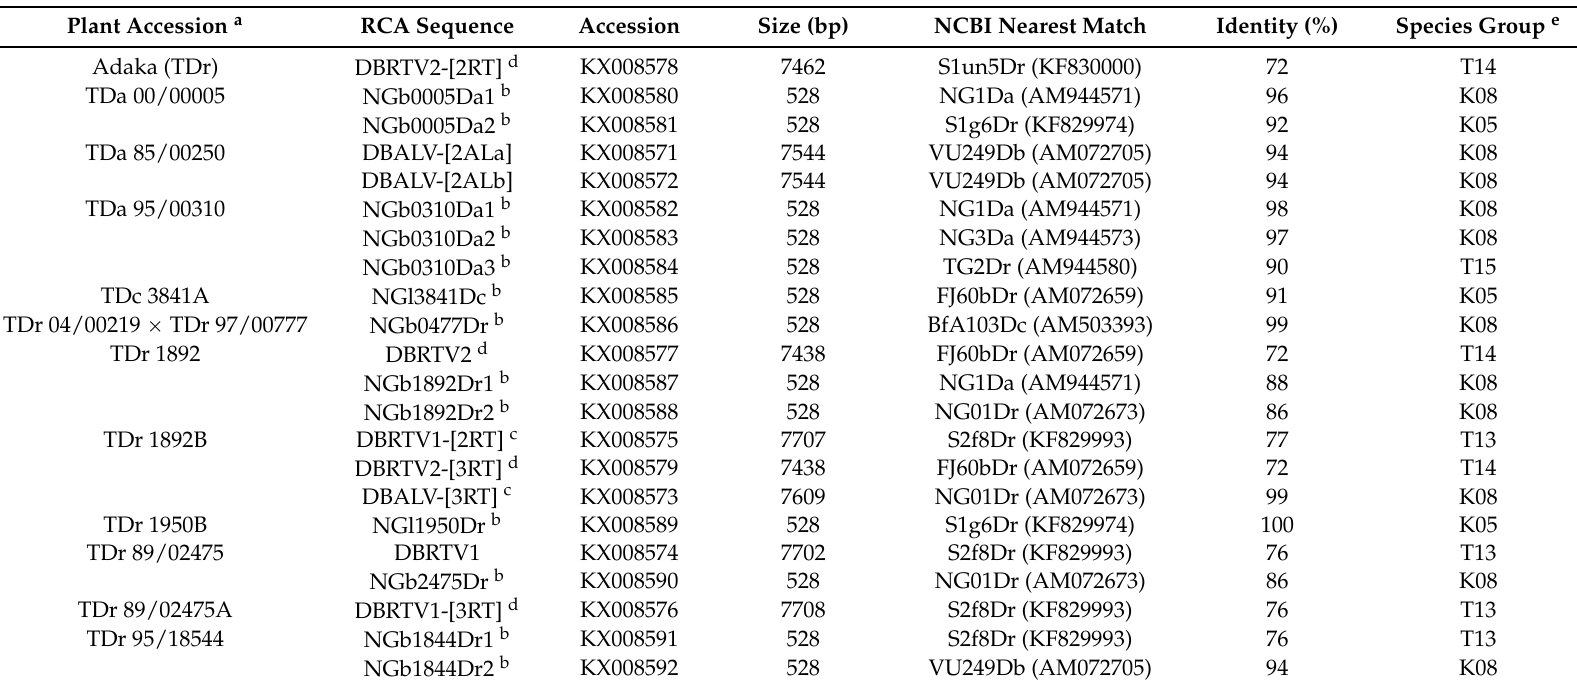
Table 1. RCA-derived sequences and BLAST analysis of their partial RT-RNaseH (528 bp) coding